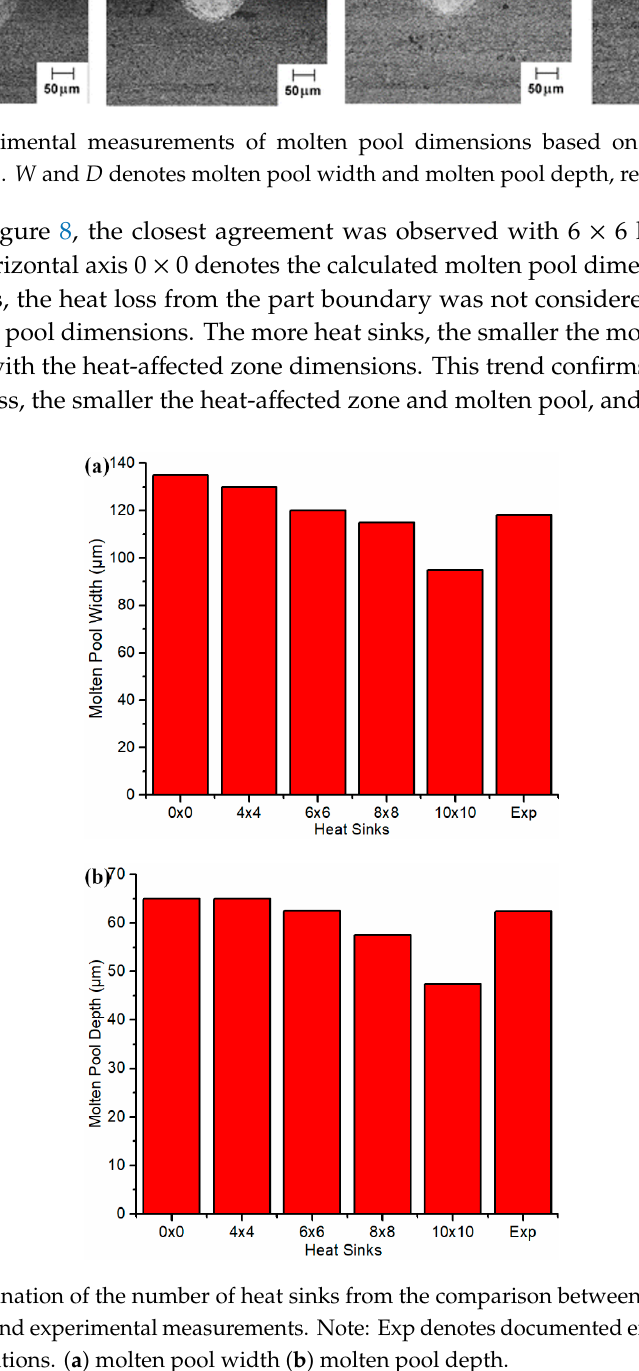
Figure 7. Experimental measurements of molten pool dimensions based on the solidification microstructure [2]. W and D denotes molten pool width and molten pool depth, respectively.